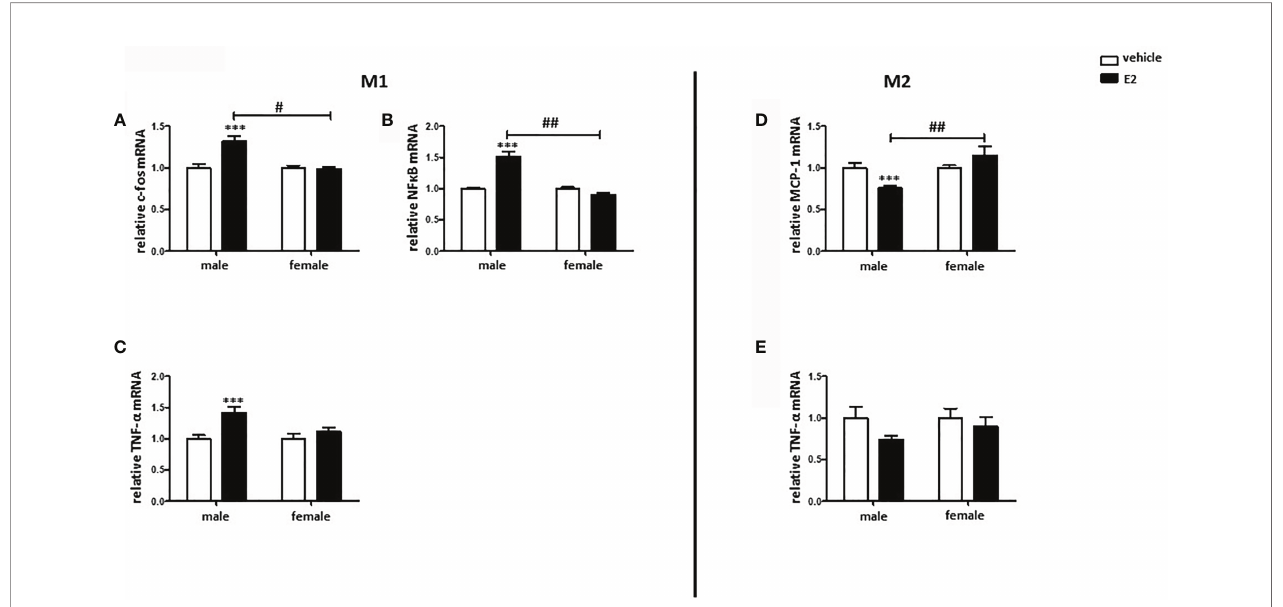
FIGURE 8 | E2 treatment promoted the pro-in fl ammatory phenotype in male BMMs. Real-time PCR analyses of (A) c-fos, (B) NF k B, and (C) TNF- a in M1 macrophages, as well as (D) MCP-1 and (E) TNF- a in M2 macrophages with or without E2 treatment (10 nmol/l) for 24 h. Data are shown as means ± SEM (n=6; independent experiments with technical duplicates). Data are normalized to vehicle. ***p < 0.001, vehicle vs. E2 treated; # p < 0.05, ## p < 0.01, male vs.